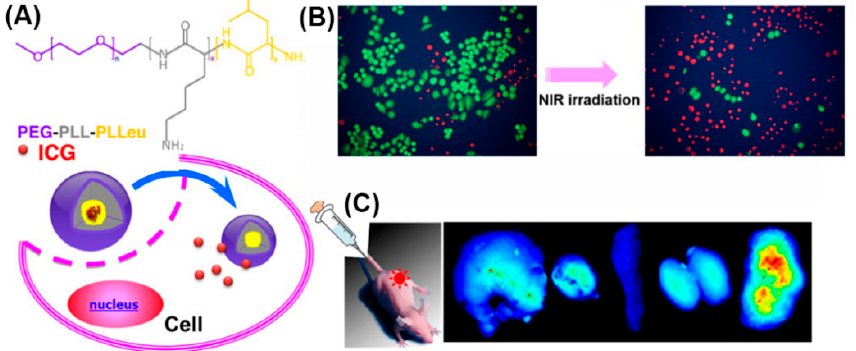
Figure 17. ( A ) Chemical structure of the PEG-PLL-PLLeu copolymer, formation of the micelle and the release behavior of ICG in cells. ( B ) Survival of H460 cells without and with 808 nm laser irradiation (green, calcein AM; red, propidium iodide). ( C ) Fluorescence images of organs and tumors in NCI-H460 tumor-bearing mice after the injection of ICG-labeled PEG-PLL-PLLeu micelles. Adapted from [187], with permission. Copyright: 2013 American Chemical Society.